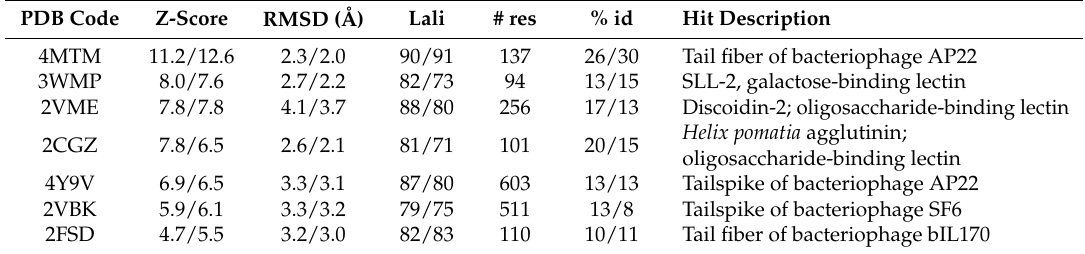
Table 3. Structural orthologs of the C-terminal domain of the R1 and R2 pyocin fibers. In all columns, the first and second number corresponds to the R1 and R2 structures, respectively. RMSD is the root mean square deviation of all aligned C α atoms. Lali stands for the number of residues used in the superposition; # res is the number of residues in the compared structure; % id is the percent of sequence identity in the compared